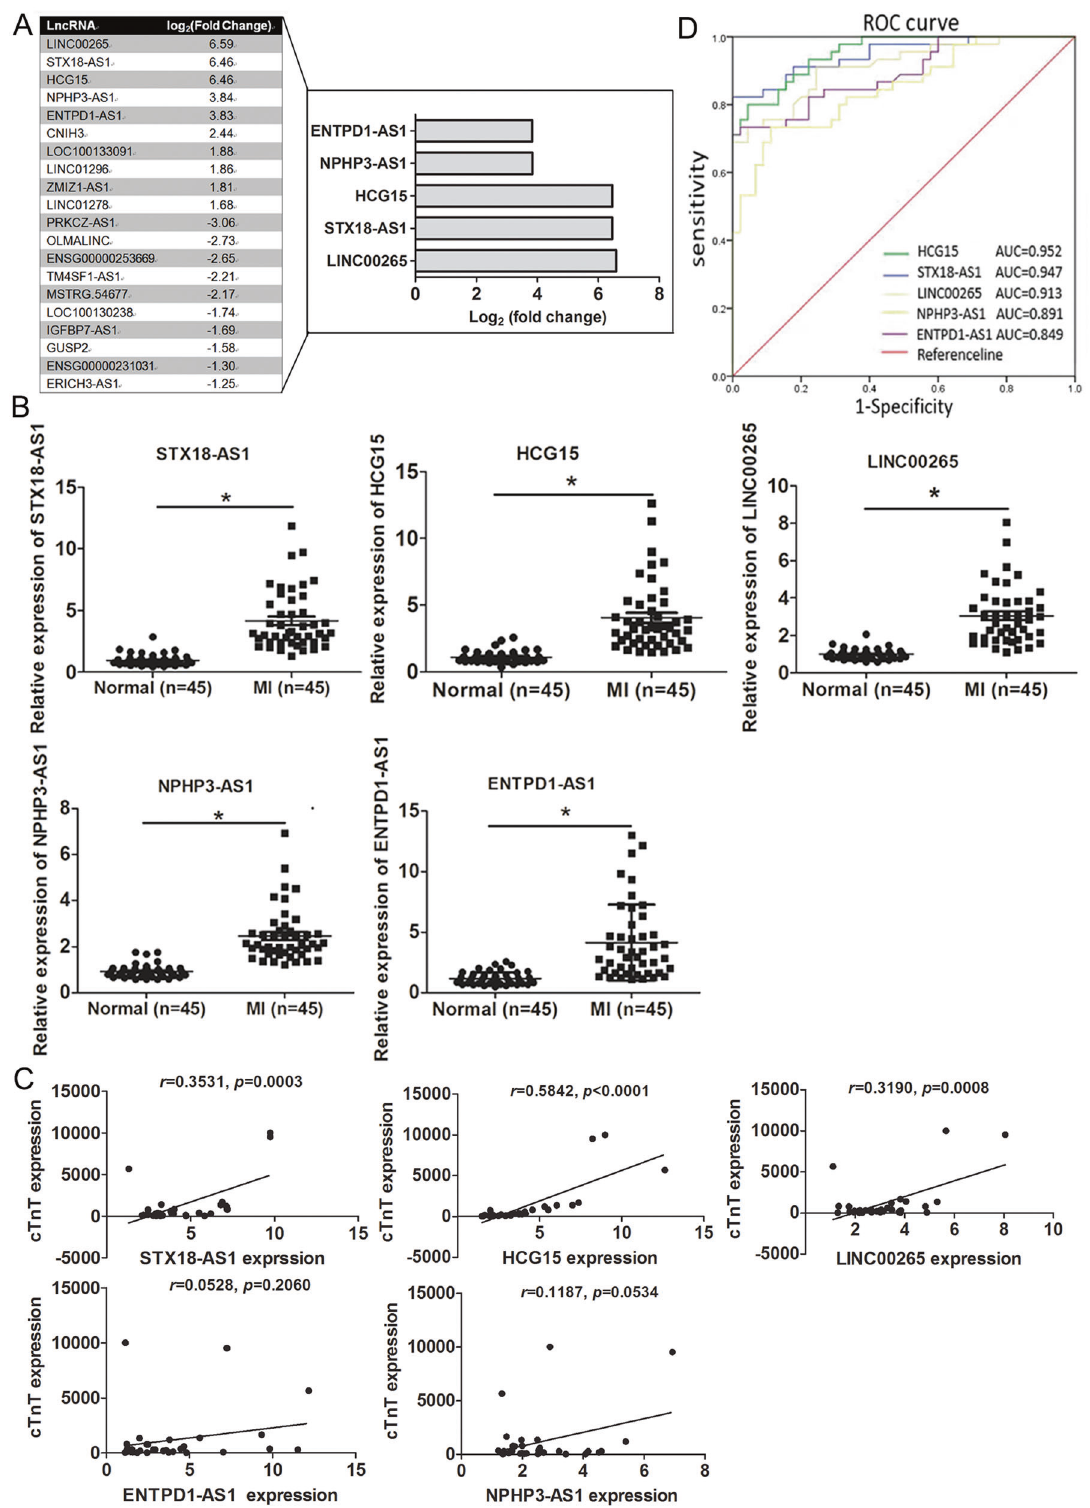
Fig. 1 Identi fi cation of the differentially expressed exosomal lncRNAs from the serum of AMI patients and healthy controls. A The top 10 lncRNAs with upregulated and downregulated expression according to the fold change value in AMI patients compared with controls and the top 5 lncRNAs with upregulated expression are shown in the bar chart. B Validation of the top 5 lncRNAs with upregulated expression in study participants by qRT-PCR. C The levels of 5 lncRNAs in exosomes derived from MI patients ’ serum were positively correlated with the cTnT concentration of AMI patients. D ROC curve analysis of the clinical diagnostic value of these 5 lncRNAs in MI. * p value < 0.05.